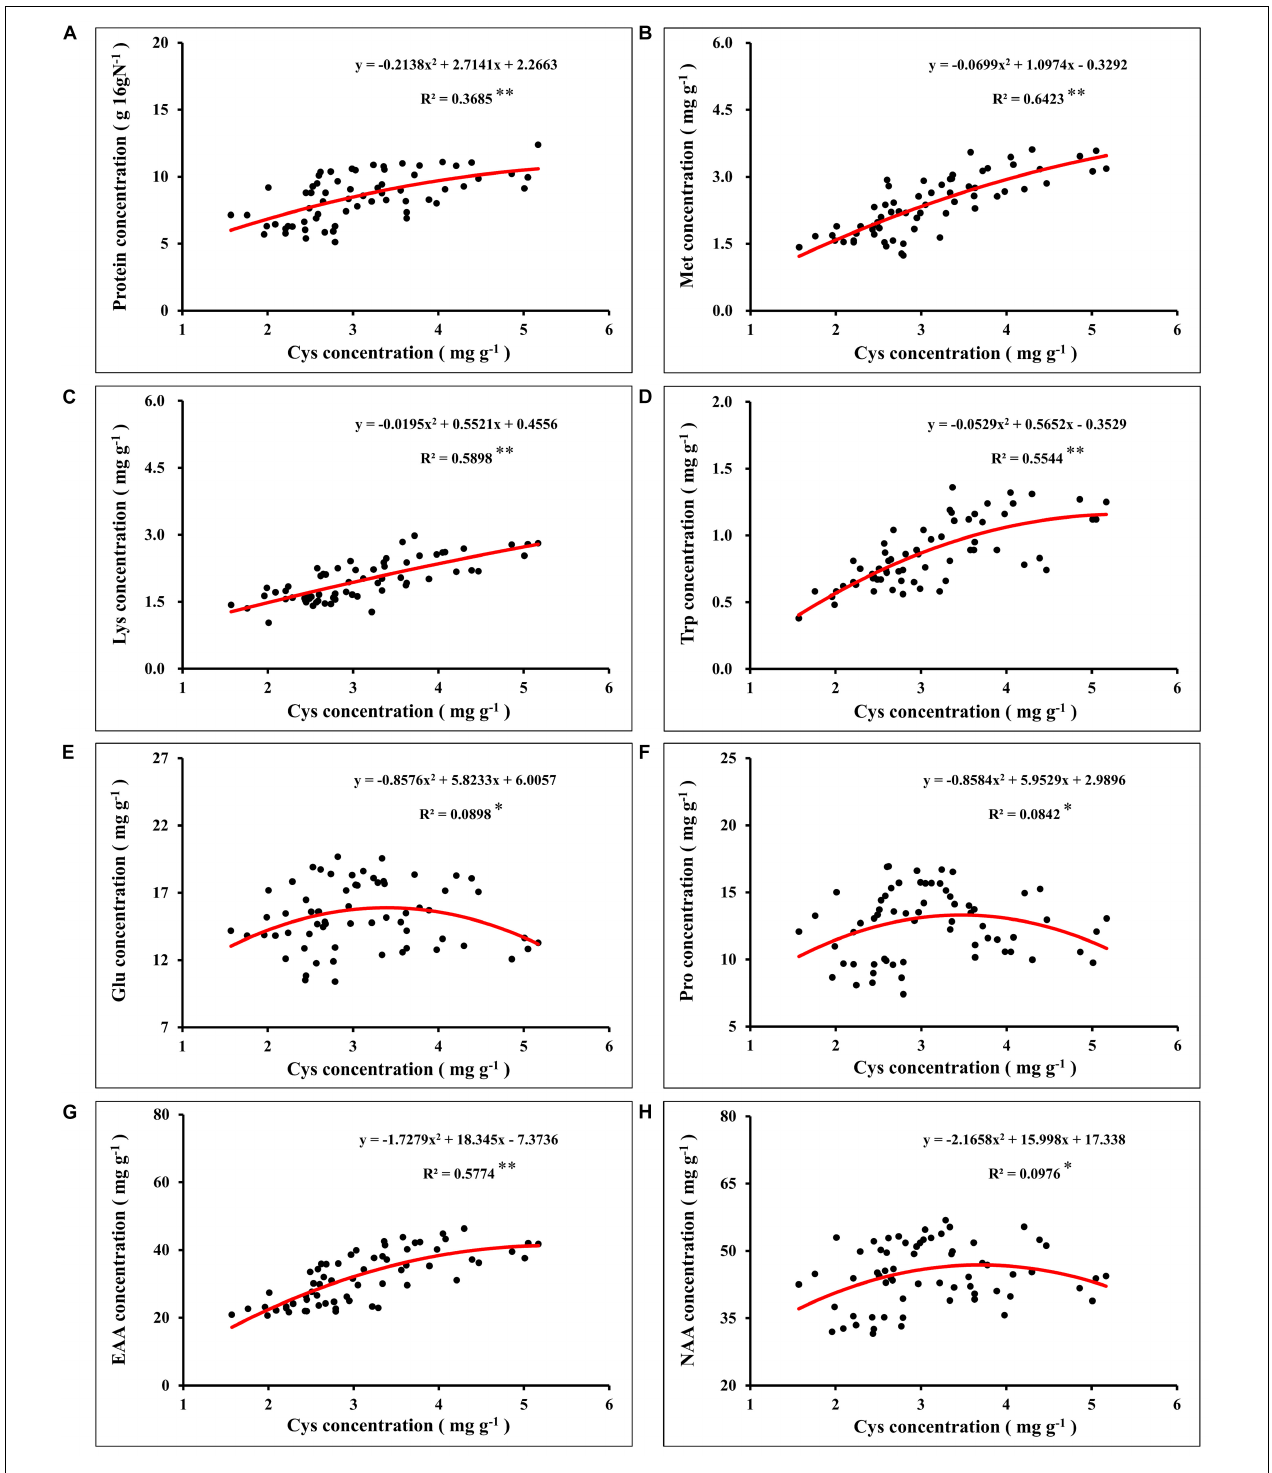
FIGURE 8 | Correlation analysis between the concentration of grain protein (A) , methionine (B) , lysine (C) , tryptophan (D) , glutamate (E) , proline (F) , total essential amino acids (G) , total non-essential amino acids (H) , and cysteine concentration in maize grains. In this image, the red curve shows the correlation between the concentration of protein, concentration of corresponding amino acids, and cysteine concentration in maize grains ( n = 64). Met, methionine; Lys, lysine; Trp, tryptophan; Glu, glutamate; Pro, proline; EAA, total essential amino acids; NAA, total non-essential amino acids.